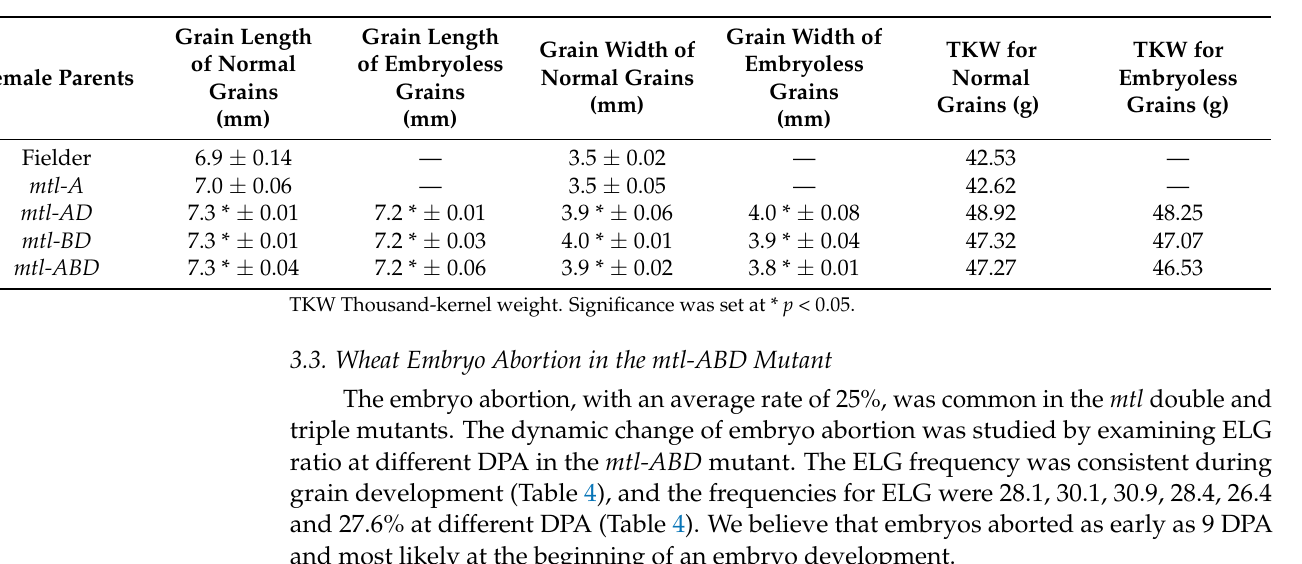
Table 3. Morphology of the normal and embryoless wheat grains of the mtl self-pollinated progenies.